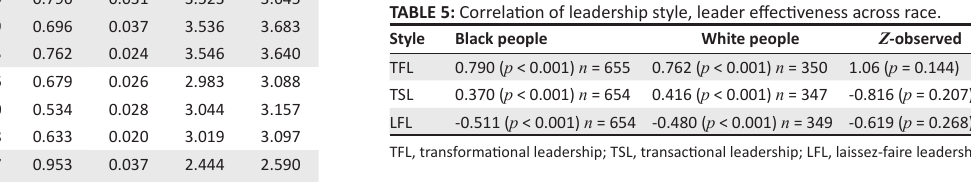
TABLE 5: Correlation of leadership style, leader effectiveness across race.